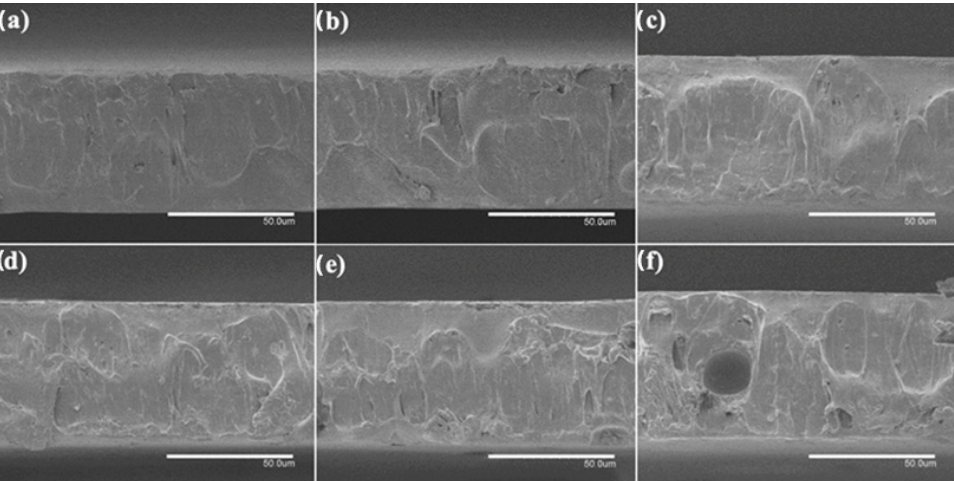
Figure 6. Comparison of the cross-section morphology for the electrospun poly(3-hydroxybutyrate- co-3-hydroxyvalerate) (PHBV) films: ( a ) 0.5 wt.% CeO 2 NPs; ( b ) 1.0 wt.% CeO 2 NPs; ( c ) 1.5 wt.% CeO 2 NPs; ( d ) 2.0 wt.% CeO 2 NPs; ( e ) 5.0 wt.% CeO 2 NPs; ( f ) 10.0 wt.% CeO 2 NPs. Images were taken by scanning electron microscopy (SEM). Scale bar corresponds to 50 µm.